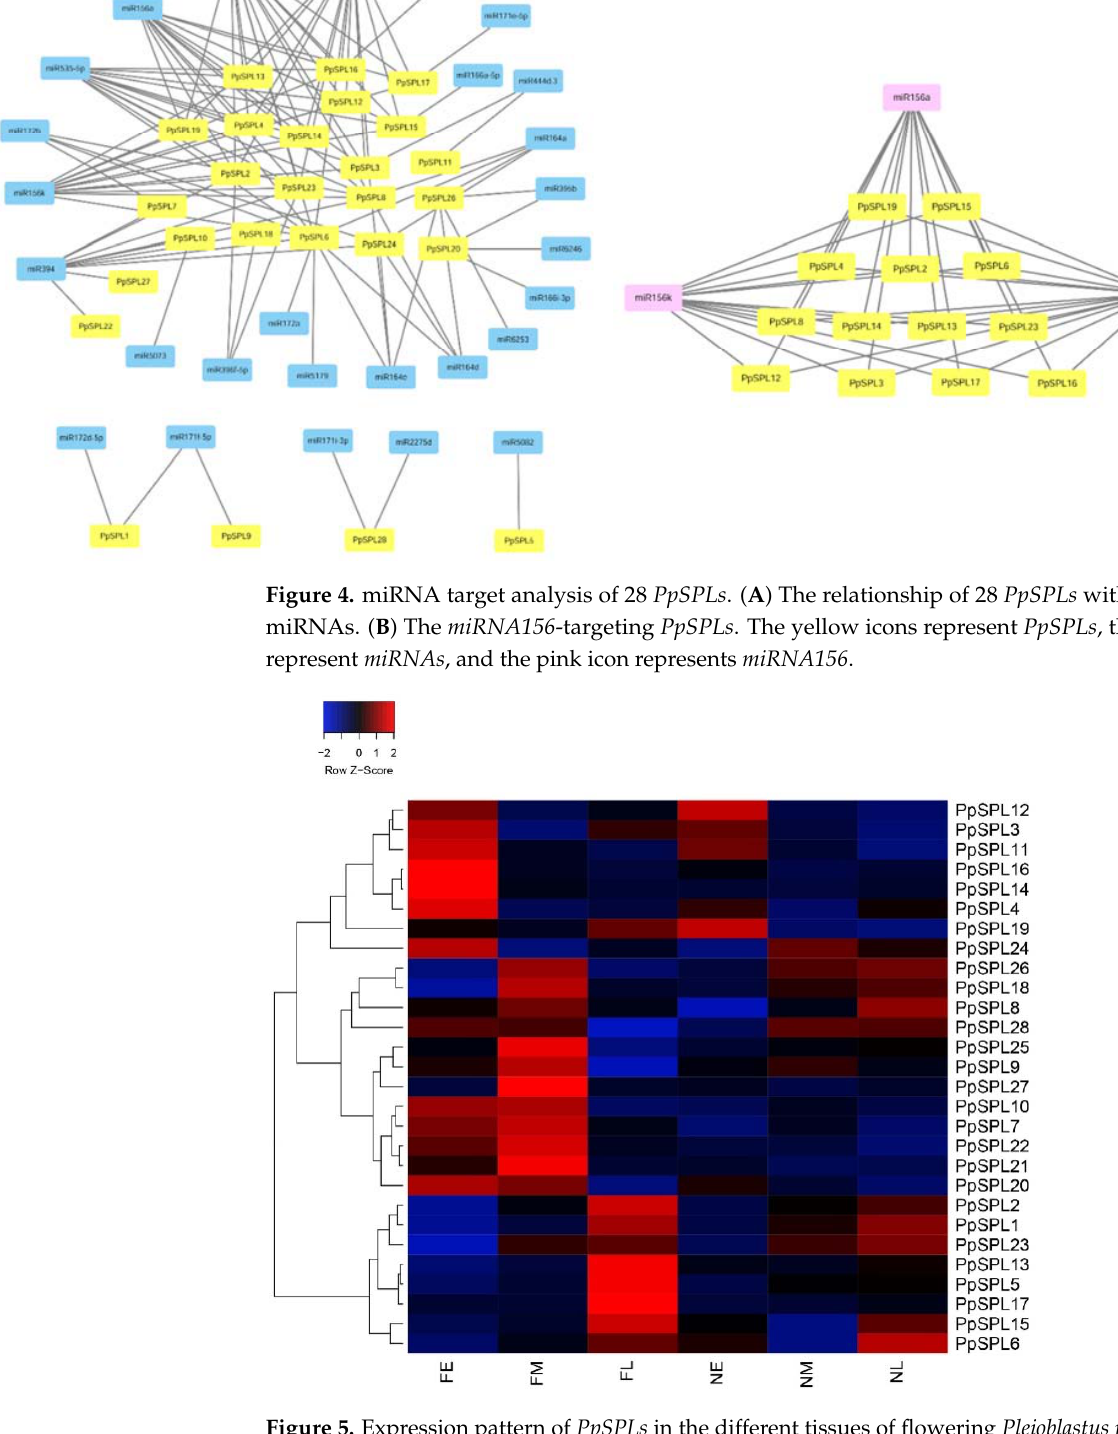
Figure 6. RT ‐ qPCR validation of significant, differentially expressed PpSPLs in Pleioblastus pygmaeus . FE, dormant shoot buds from flowering P. pygmaeus ; FM, germinated shoots from flowering P. pyg ‐ maeus ; FL, flower buds from flowering P. pygmaeus ; NE, dormant shoot buds from non ‐ flowering P. pygmaeus ; NM, germinated shoots from non ‐ flowering P. pygmaeus ; NL, leaf buds from non ‐ flower ‐ ing P. pygmaeus ; PCR, relative expression level by RT ‐ qPCR; DEG, differentially expressed gene by